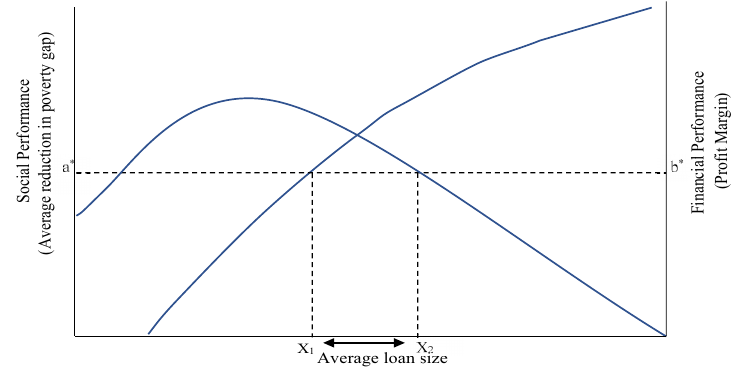
Figure 1. MFIPerformance in relation to loan